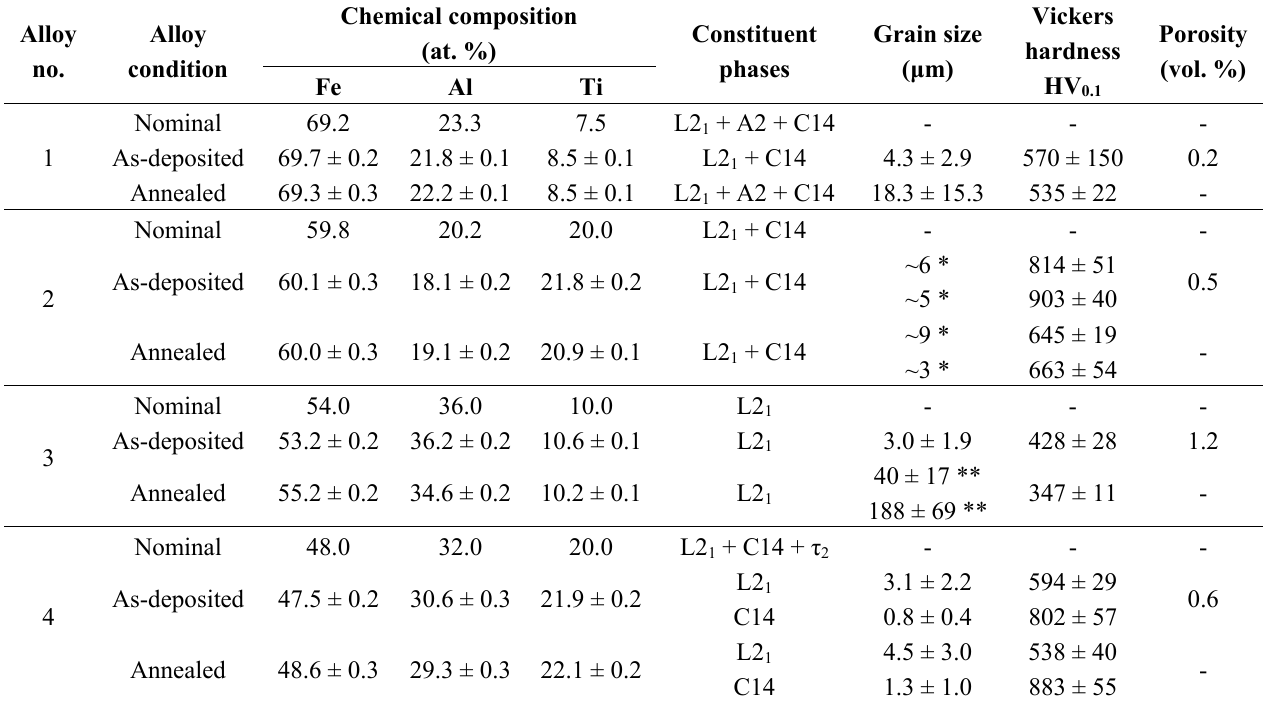
Table 1. Nominal and obtained chemical compositions of the Fe-Al-Ti alloys and the phase content, grain size, hardness and porosity after laser deposition and annealing at 1000 °C for 20 h with furnace cooling.